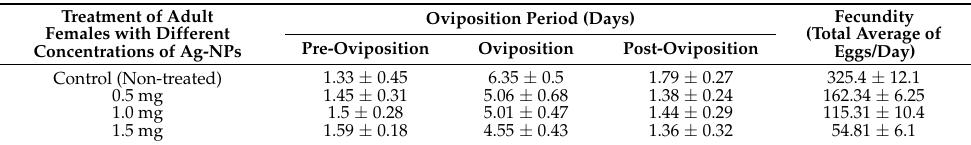
Table 2. Duration times of adult females of T. putrescentiae fed on wheat mixed with different Ag-NPs concentrations during pre-oviposition, oviposition, and post-oviposition periods, and the fecundity at 25 ± 2 ◦